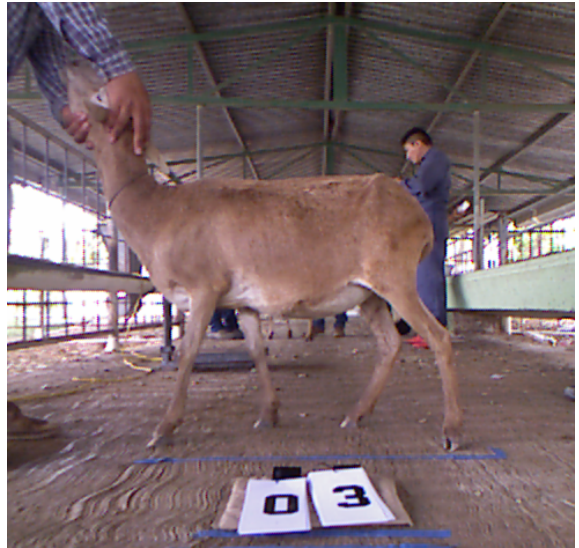
Figure 3. RGB image from the Kinect ® sensor.